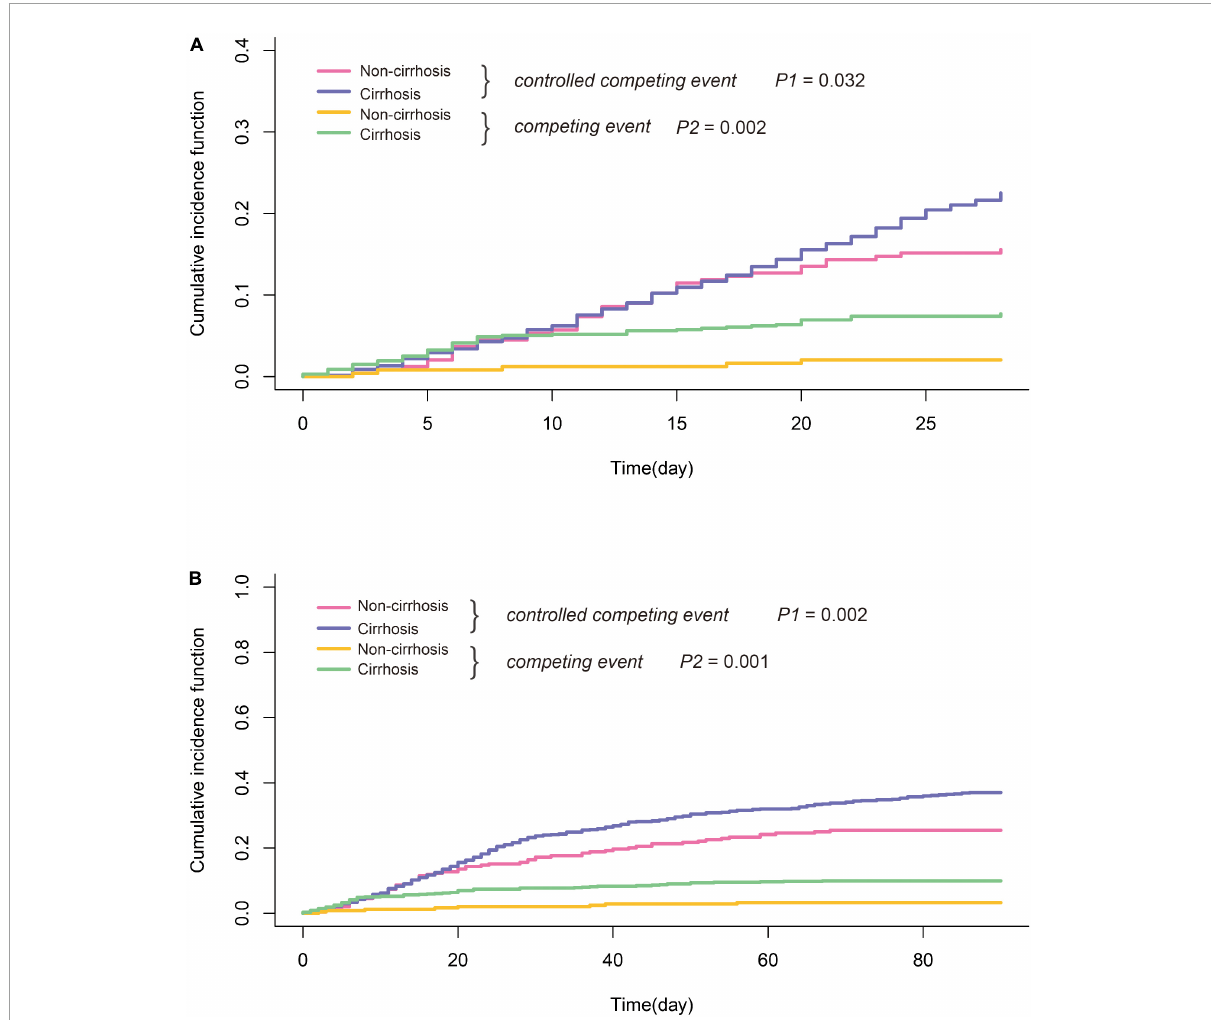
FIGURE2 Comparison of short-term survival of HBV-ACLF with or without cirrhosis (A) 28-day and (B) 90-day; liver transplantation was considered as competing events. Statistical analysis was performed by cumulative incidence function. P1: HBV-ACLF with cirrhosis vs. HBV-ACLF without cirrhosis after controlling for competing risk. P2: HBV-ACLF with cirrhosis vs. HBV-ACLF without cirrhosis without controlling for competing